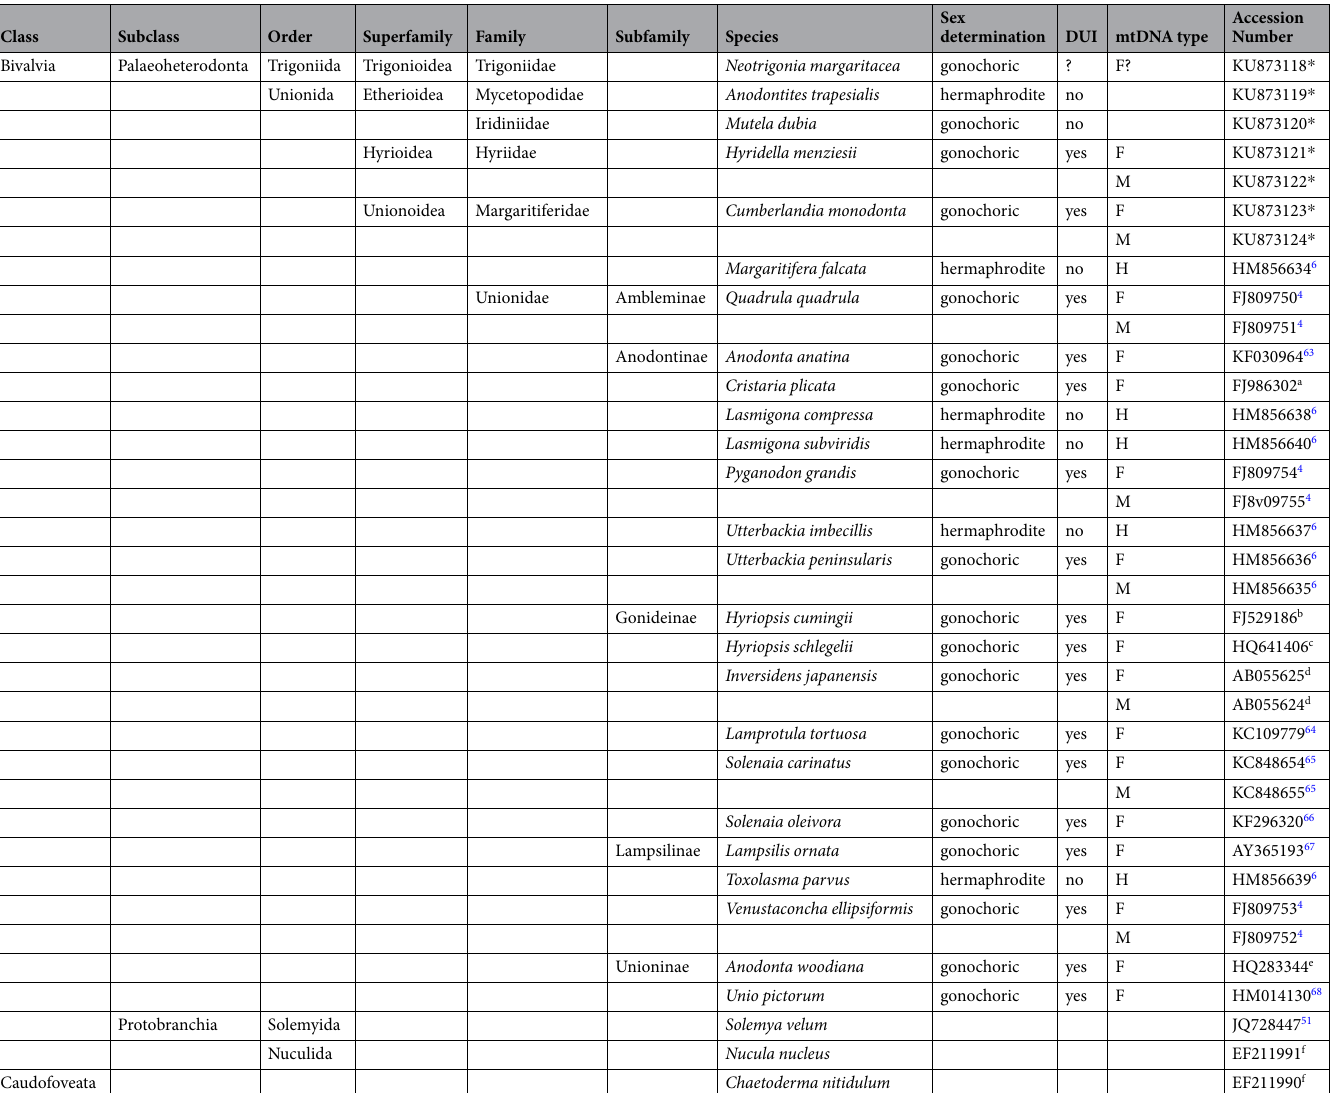
Table 1. List of species and respective mtDNAs considered in this study. For each species, the respective sex determination system and the presence of DUI is specified (DUI occurrence is uncertain at present in N . margaritacea ). For each mtDNA, GenBank accession number and respective reference are indicated. mtDNA type F or M is indicated for DUI species only; N . margaritacea mtDNA here considered might be an F if DUI will be confirmed in this species. H type is indicated only for unionid species who secondarily lost DUI and became hermaphroditic. References for each sequence are indicated with superscripts after the accession numbers: asterisks ( * ) indicate sequences obtained in this study; numbers published data; and